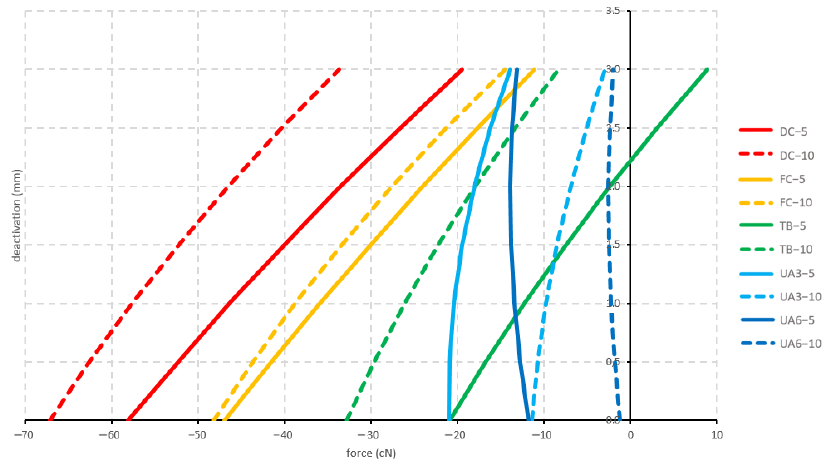
Figure 12. Vertical forces generated by the straight configurations during deactivation. Tested cantilever configurations origin from Figure 2.